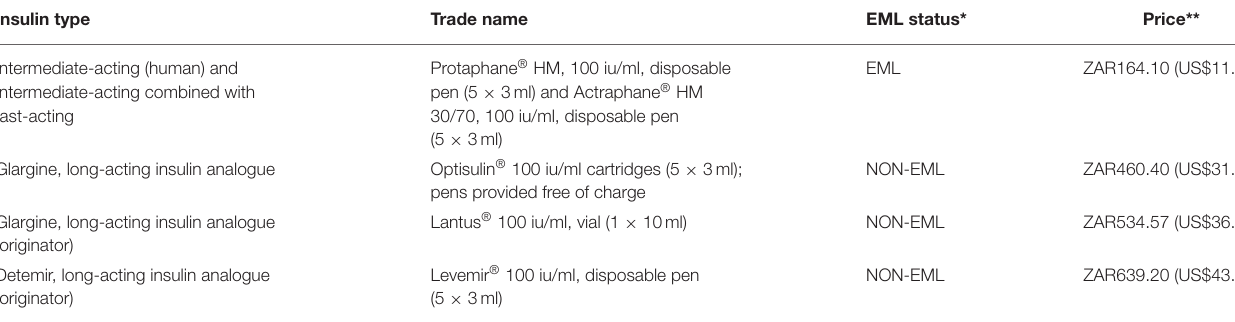
TABLE 2 | Current contract prices for different insulin preparations among public hospitals in South Africa. Insulin